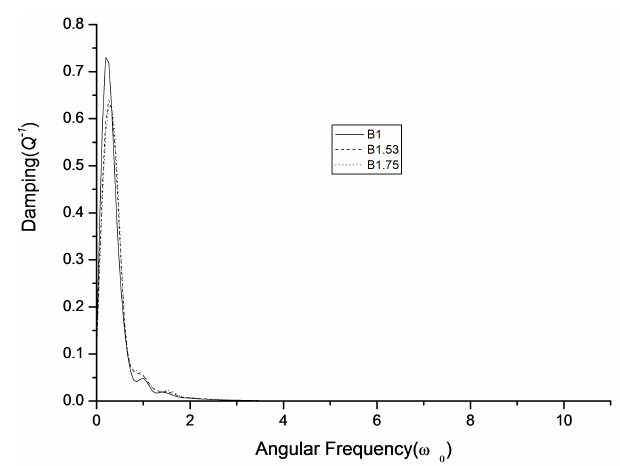
Figure 6: Variation in damping with respect to angular frequency ( α = 1) .